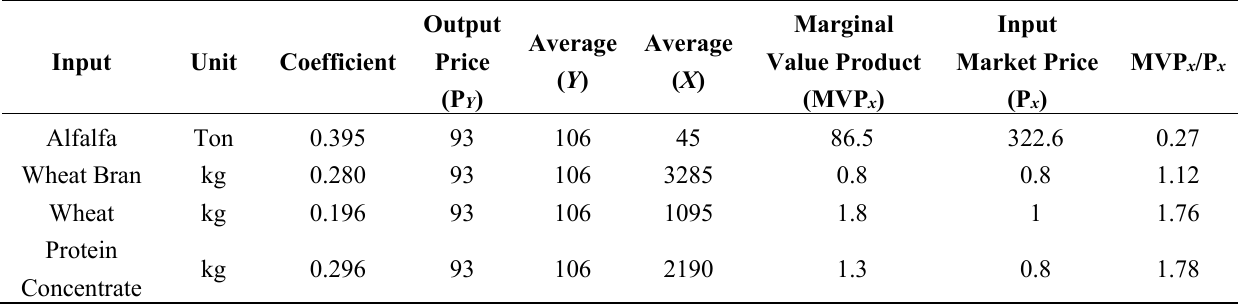
Table 3. Allocative efficiency of inputs for goats. MVP, marginal value